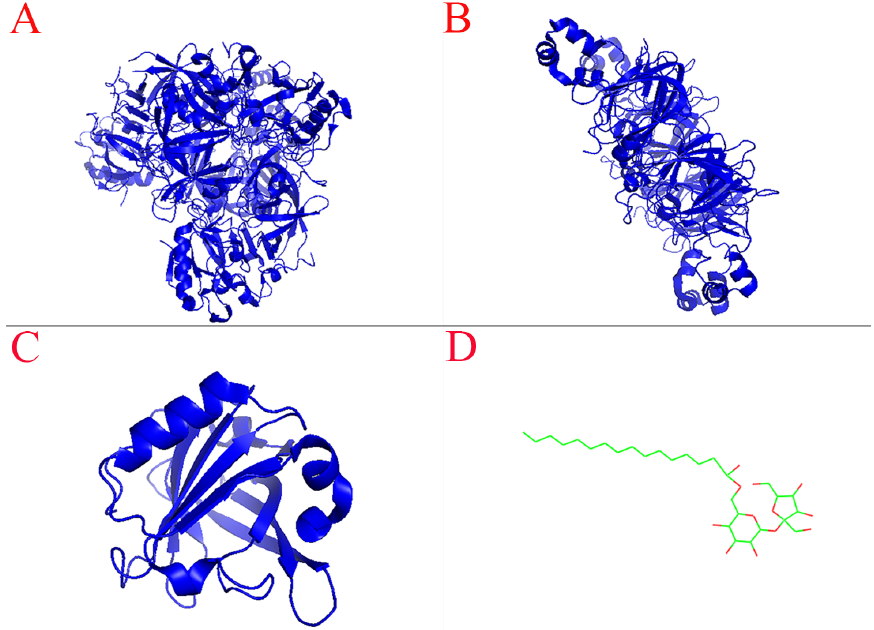
Figure 6. Chemical structure of 7S globulin, 11S globulin, β -lactoglobulin and sucrose ester. (( A ), 7S